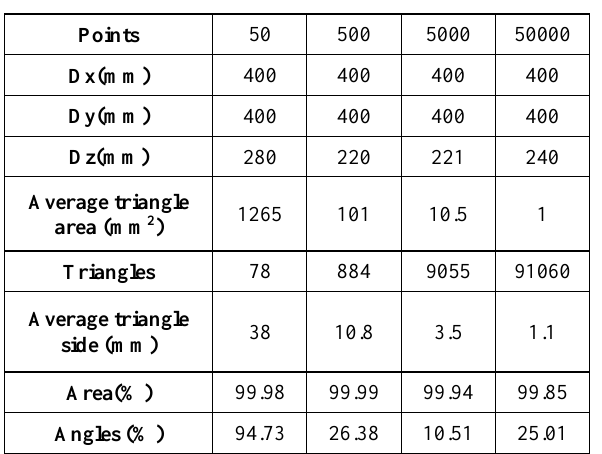
Table 4. Results of the four applications of the